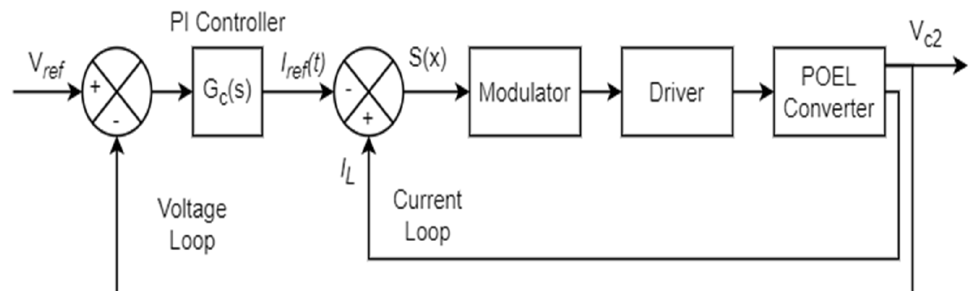
Figure 6. A dual-loop sliding-mode control scheme.